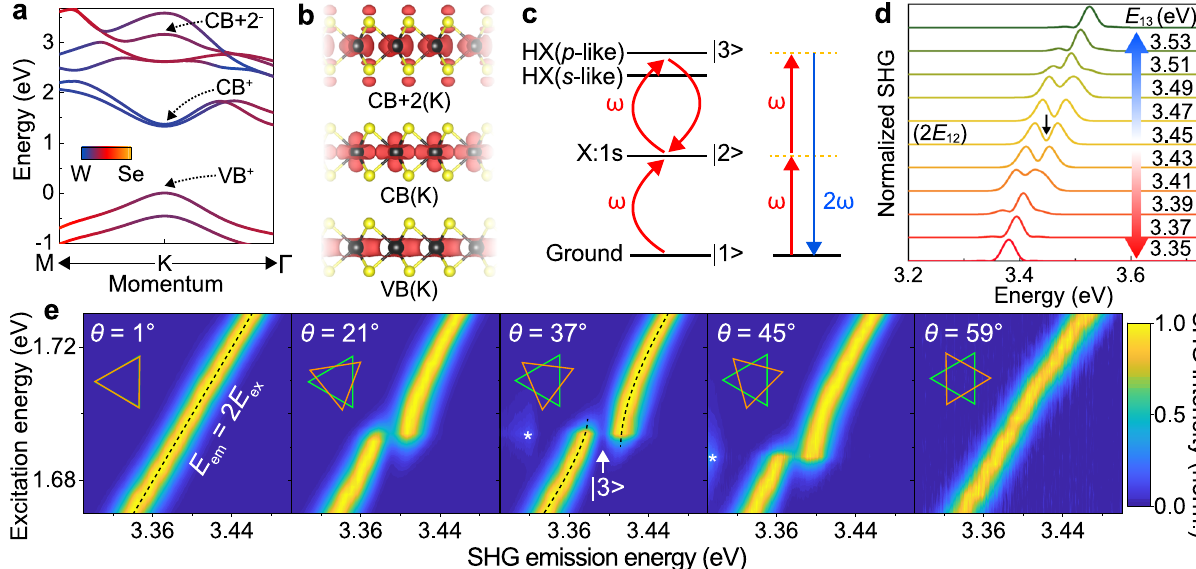
Fig. 2 Twist-angle dependence of quantum interference in an optical second-harmonic generation (SHG) from bilayer WSe 2 . a Band structure of monolayer WSe 2 from DFT calculations. The X arises from transitions between the top valence band VB + band to the upper spin-split fi rst conduction band CB + , and the HX results mainly from transitions between VB + and CB + 2 − . The color code indicates the wavefunction projection around each atom, illustrating the atomic-orbital contributions to the energy bands. At the K-points, the high-lying bands CB + 2 have a much greater contribution from selenium atoms than the CB band. b Partial charge densities (red) of the states from VB, CB, and CB + 2 at the K-points, which was calculated for monolayer WSe 2 without spin – orbit coupling. For states from the VB and CB, the charge is localized around the tungsten atoms (black spheres). For the state from CB + 2, the charge appears to be more delocalized and extends to the selenium atoms (yellow spheres). In bilayers, the HX is therefore expected to be more sensitive to twisting than X when hybridization occurs between layers. The isosurface levels are set to 0.01 e/Bohr 3 . c Illustration of the excitonic three- level system, where 1 j i is the ground state, 2 j i is associated with the 1 s state of the A-exciton X:1 s , and 3 j i is associated with the p- like high-lying exciton HX. Strong driving by an ultrashort laser pulse (red arrows) centered at a frequency ω dresses state 2 j i and drives quantum interference between the three states. At the same time, the laser pulse gives rise to SHG (blue arrow), which probes the interference. d As captured by time-dependent density-matrix simulations, tuning the energy of state 3 j i while keeping state 2 j i at 1.725 eV allows the quantum-interference feature, which shows up as a dip in the SHG spectrum, to be effectively turned on and off. The dip in the SHG spectrum marks the energy of state 3 j i as illustrated by the black arrow for the case of E ¼ 3 : 45eV. e Experimental twist-angle ( θ ) dependence of normalized SHG from bilayer WSe 2 at 5 K, measured with 80 fs excitation pulses. The 13 normalized SHG intensity is plotted as a function of emitted photon energy (horizontal axis, E em ) and central photon energy of the excitation laser (vertical axis, E ex ). The UPL feature is marked by asterisks. The SHG follows the canonical linear dependence on the excitation energy ( E em = 2 E ex , black dashed line in the left panel), as shown in the 1° and 59° twisted bilayers. Anti-crossing behavior (black dashed lines in the middle panel) becomes apparent when quantum interference occurs, as shown in the 21°, 37°, and 45° twisted